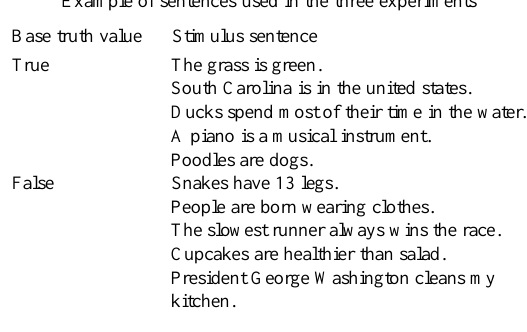
Table 2 Example of sentences used in the three experiments Base truth value Stimulus